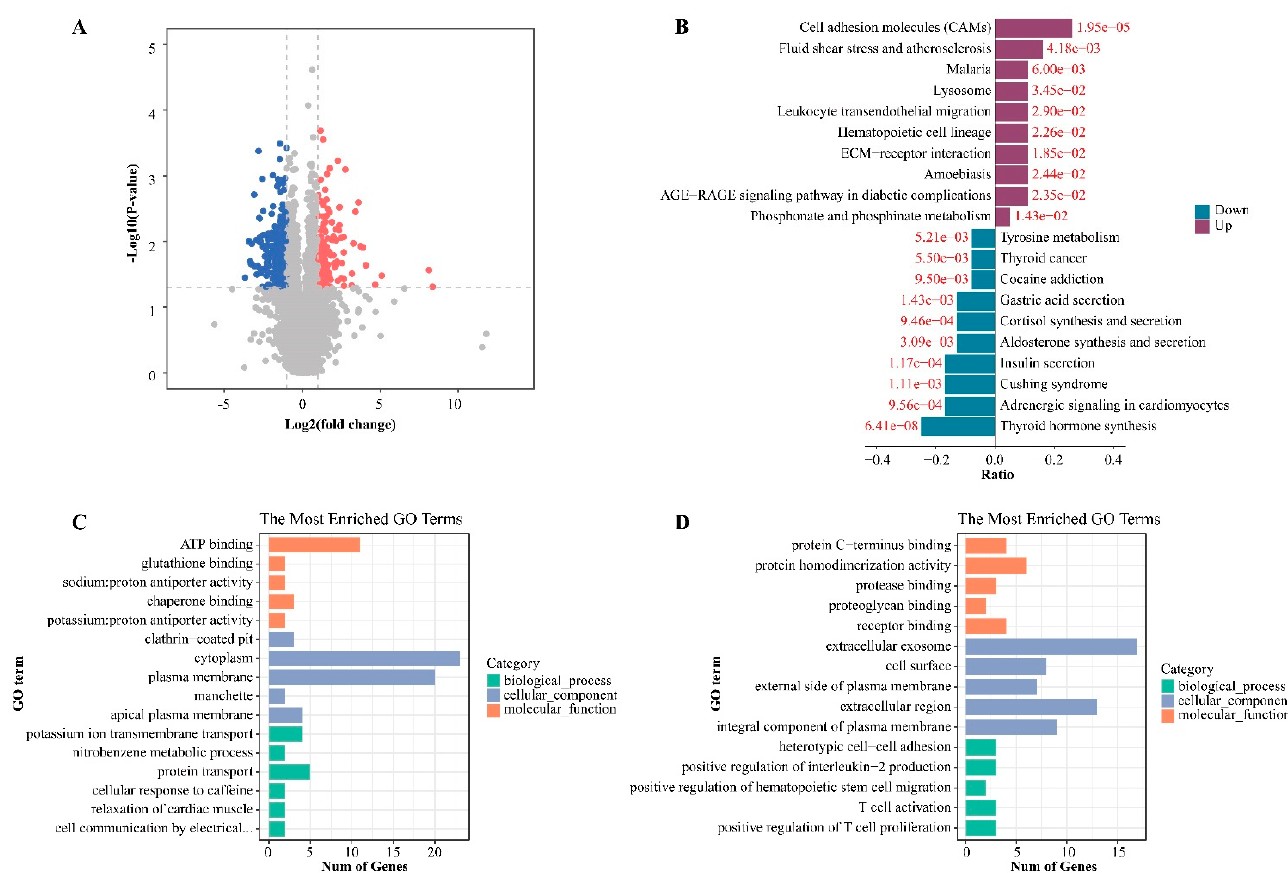
Figure 2. The whole-genome transcriptome profile of papillary thyroid carcinoma. ( A ) Volcano plot showing transcriptome difference between thyroid nodules and PTC. ( B ) The top 10 KEGG enrichment analysis results of genes with significant expression differences. ( C ) The top 5 GO enrichment analysis results of significantly down-regulated genes. ( D ) The top 5 GO enrichment analysis results of significantly up-regulated genes.